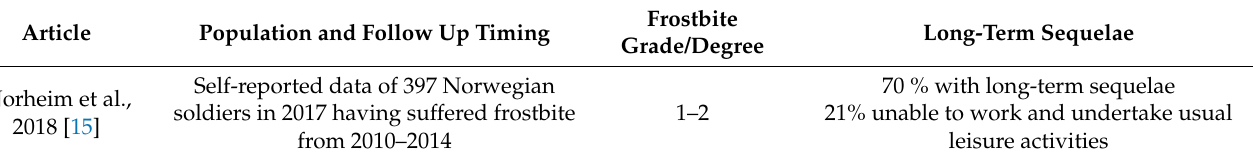
Table 2. Studies reporting frostbite long-term